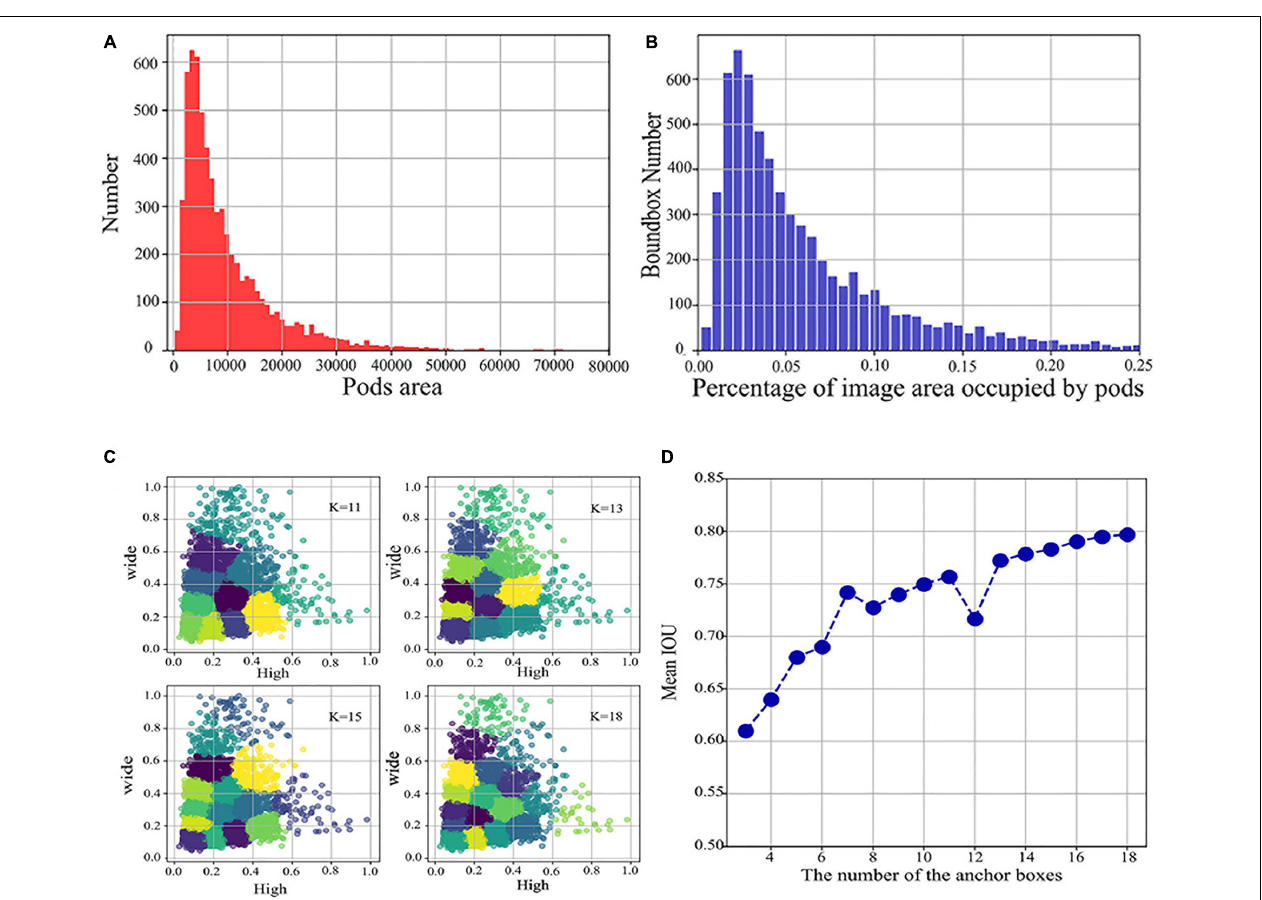
FIGURE 2 | Distribution of pods area and percentage and determining the number of anchor boxes versus the aspect ratio. (A) Distribution of the number of different pods areas. (B) Distribution of the percentage of the image area occupied by different pods. (C) Plots of clustering effects for different K values. (D) A plot of the number of different anchor boxes versus Mean